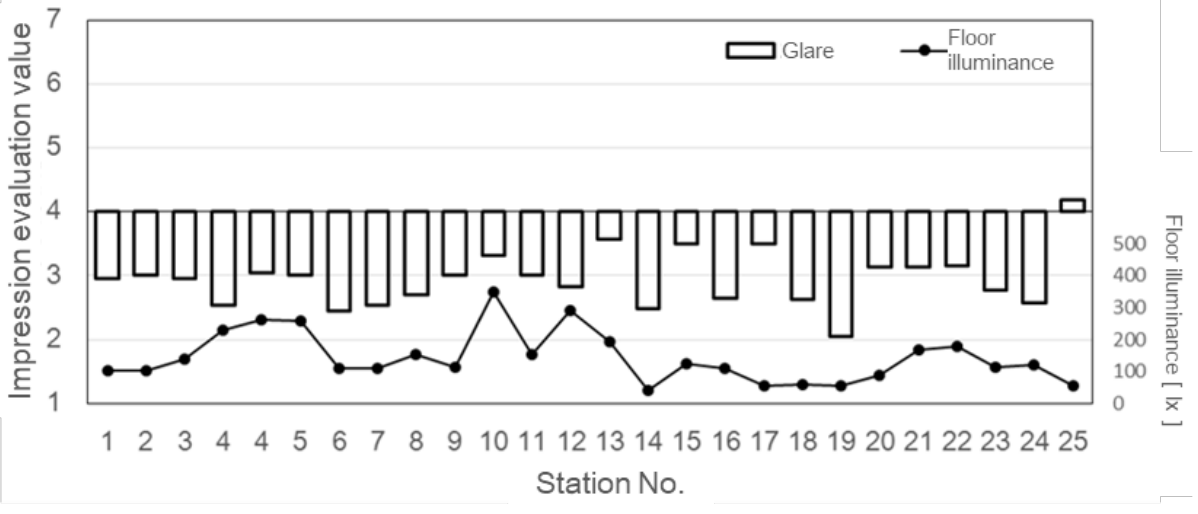
Figure 14. Font views of the No. 15 ( left ) and No. 25 ( right ) platforms.